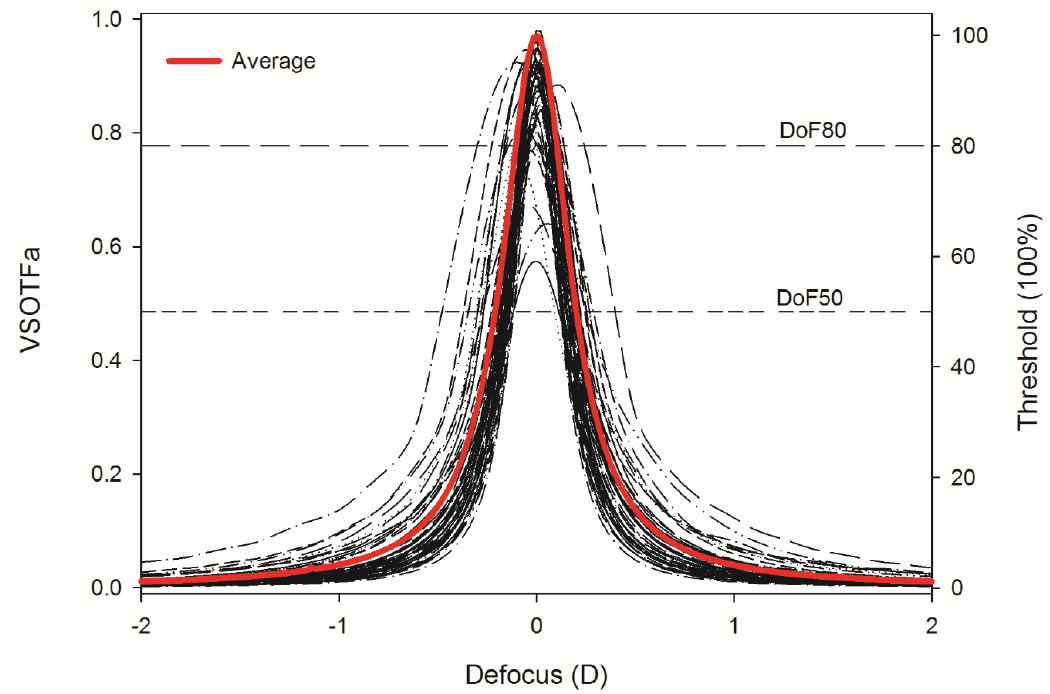
Figure 3. Through-focus VSOTFa analysis of each participant at maximum accommodation. Dashed lines represent 50% and 80% thresholds of the maximum IQ. DoF50 and DoF80 are the estimated values of objective DoF for the 50% threshold and the 80% threshold respectively.